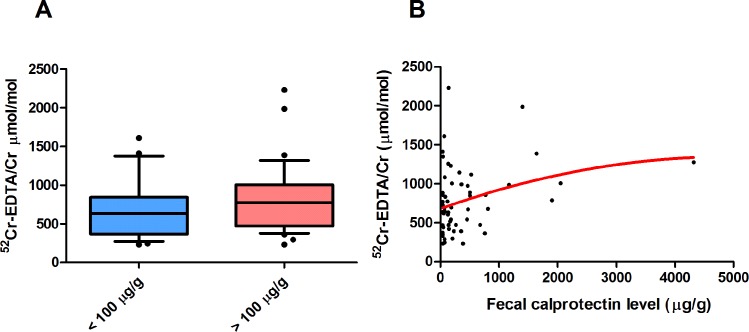
The relationship between levels of urinary 24-h 52Cr-EDTA/creatinine excretion and fecal calprotectin.(A) Distribution of urinary 52Cr-EDTA/creatinine excretion in patients with low (blue, < 100 μg/g) and increased (red, > 100 μg/g) fecal calprotectin levels, shown in boxplots. (B) Urinary 52Cr-EDTA/creatinine excretion significantly correlates with fecal calprotectin levels (ρ = 0.325, P < 0.05), as represented by the red smoothed curve.